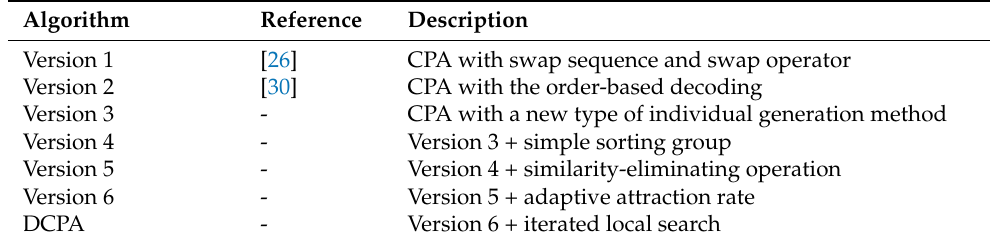
Table 5. Description of different versions of the